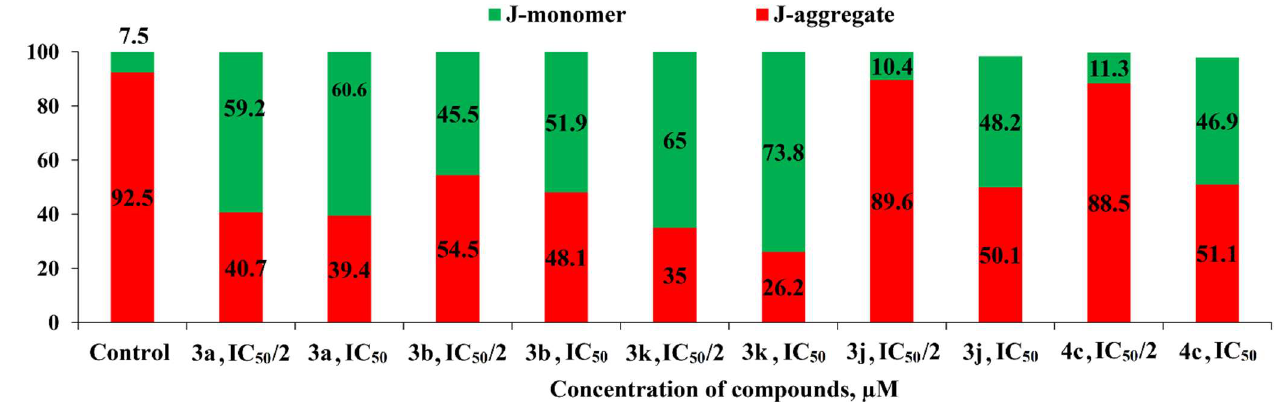
Figure 6. Quantitative determination of % cells with red aggregates.